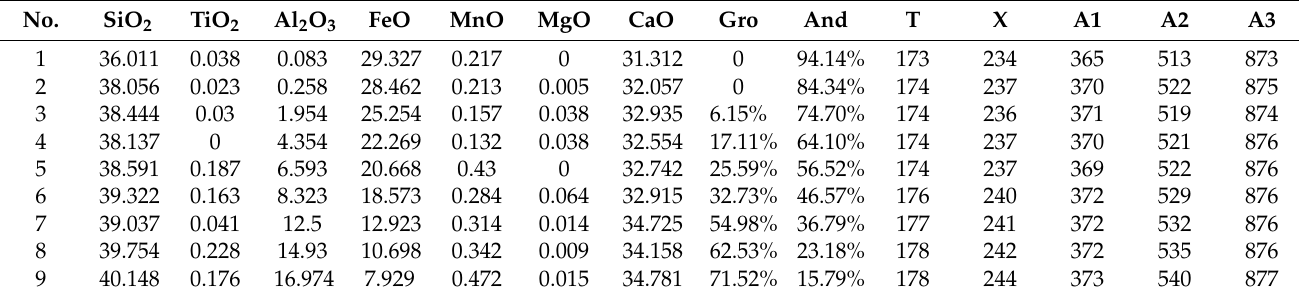
Table 3. EPMA data (wt%) and Raman peaks (cm − 1 ) of nine groups of garnets.